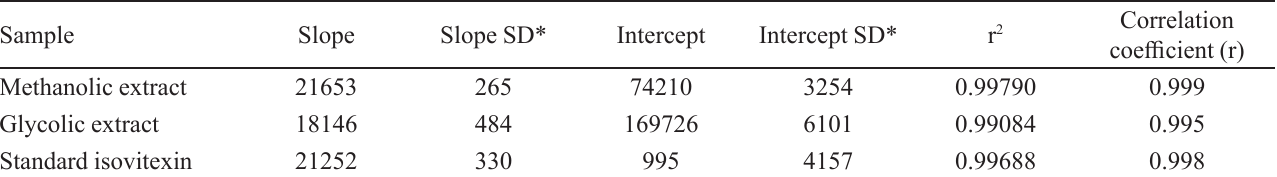
TABLE II - Analytical curves parameters Sample